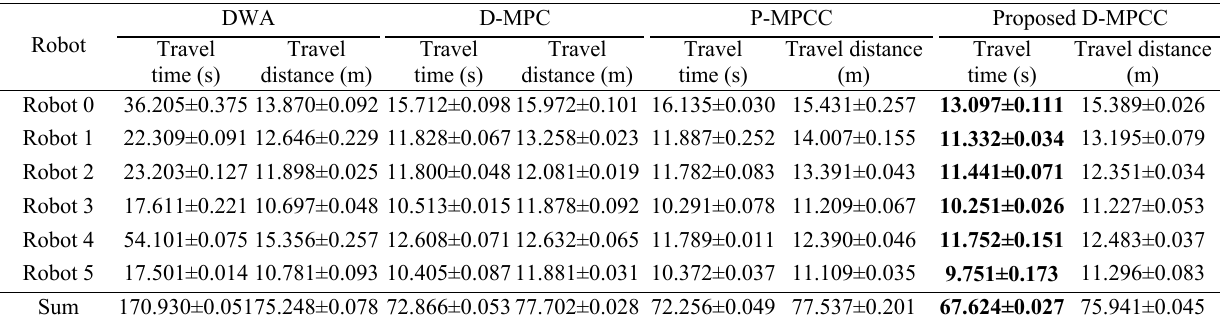
Table 4 Comparison of travel time and distance using different methods.